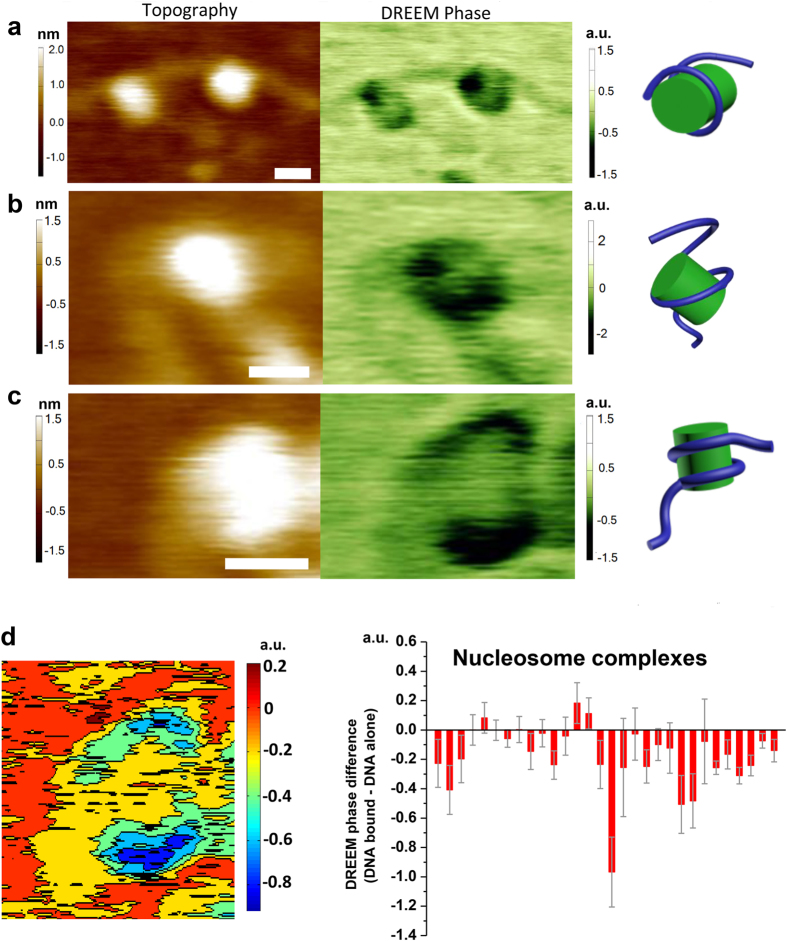
DREEM imaging reveals DNA wrapping around nucleosomes purified from HeLa Cells.(a–c) Topographic AFM images (left), DREEM phase (middle), and models (right) of nucleosomes purified from HeLa cells. In DREEM phase images, proteins and DNA show negative signals relative to the mica surface, with the proteins producing greater contrast (darker regions). The XY scale bars are at 10 nm. (d) The difference in DREEM phase signals from DNA bound by histones and DNA alone reveals signal transitions from DNA to histones. Left: a contour map of the nucleosome shown in (c). Right panel: Statistical analysis of the DNA DREEM phase signal difference (DNA bound – DNA alone, N = 30) for individual nucleosome complexes. Each bar represents the difference between DREEM phase signals from DNA bound by histone proteins and DNA alone in the same images. The DREEM signals from DNA were obtained by drawing a line over a segment of DNA. The error bars represent standard deviations of DNA signals. The error bars represent standard deviations of the measurement.